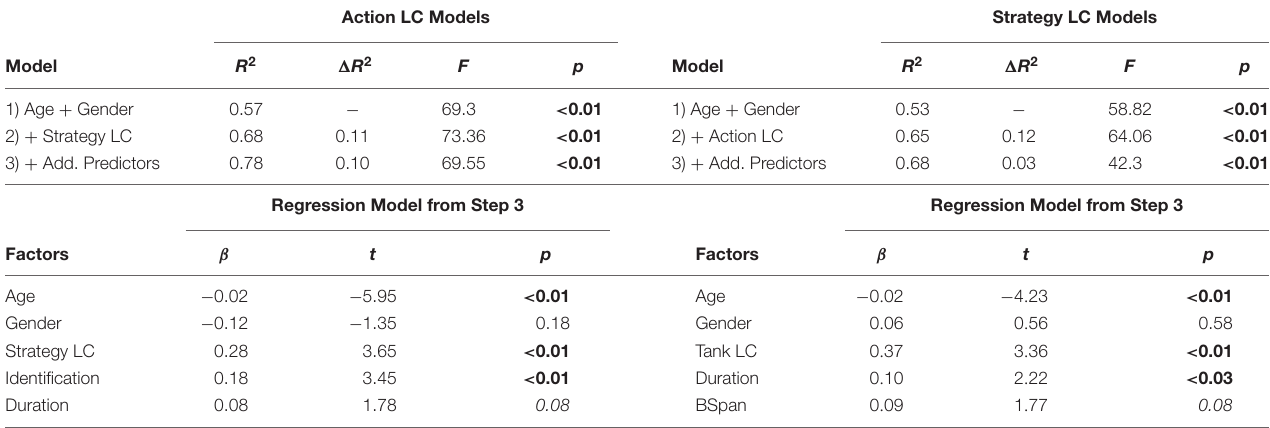
TABLE 4 | Results from follow-up regression models, after controlling for opposite game